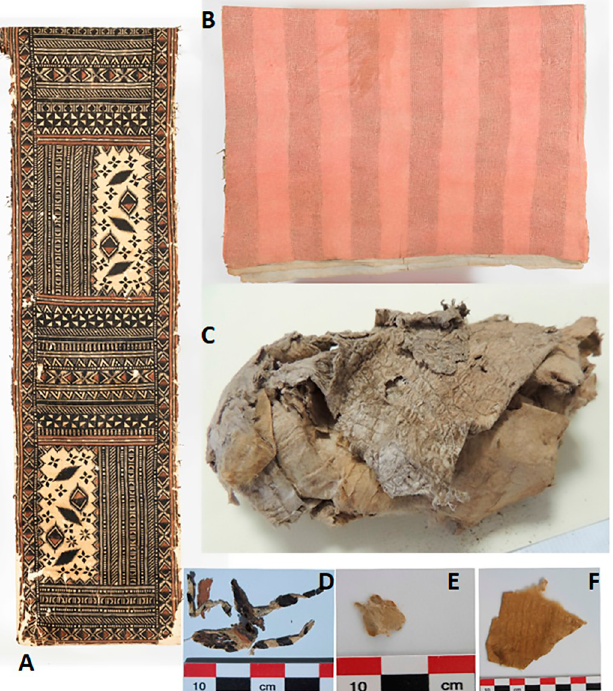
Fig 1. Examples of barkcloth textiles sampled for this study. (A) Painted tapa from Fiji (1928, Honolulu Museum of Art Catalogue #2506). Donated to the Museum in 1928. Size of tapa 61.6 x 350.5 cm. (B) Multilayered bed tapa (Kapa Moe) from Hawaii (Honolulu Museum of Art, Catalogue #662.1). Size: 208 cm x 281 cm. (C) Gambier Islands textile from a funerary context. Four bags containing large number of pieces that range in size from a few cm in length and width to approximately 15 x 25 cm. Image of contents of Bag A. (D) Sample BQUCHTE008 taken from the Fijian tapa (Fig 1A). E. Sample BQUCHTE005 was taken from a Hawaiian tapa piece (Fig 1B). (F) Sample BQUCHTE016 taken from the Gambier Island tapa [20], Bag B2. Scale bar divisions: 1